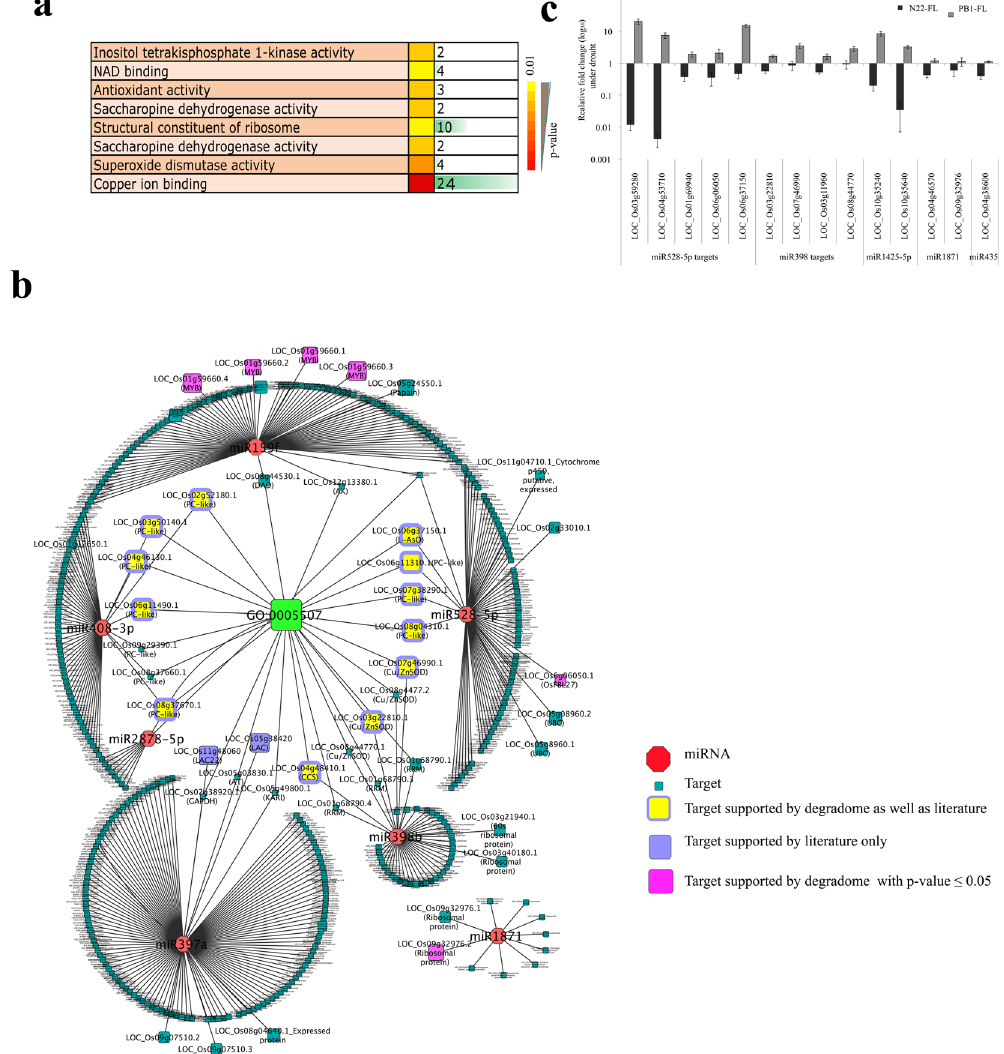
Figure 3. Identification and validation of CSDR-miRNA targets. ( a ) Molecular function enrichment analysis showing the enrichment of “GO:005507-Copper-ion binding” among the CSDR-miRNA targeted 402 genes. Targets were identified through degradome as well as literature. ( b ) CSDR-miRNA:target interaction map showing the association of most valid targets with GO:005507 (Copper ion binding) term. The target node size corresponds to degradome read number (smallest node ≤ 10 reads and biggest node with ≥ 200 reads). ( c ) Expression analysis of genes targeted by miR528-5p, miR398b, miR1425-5p, miR1871 and miR435. For each real-time expression analysis, at least three biological replicates with three technical replicates were analyzed here. The error bars represent the standard error. Actin was used as the endogenous